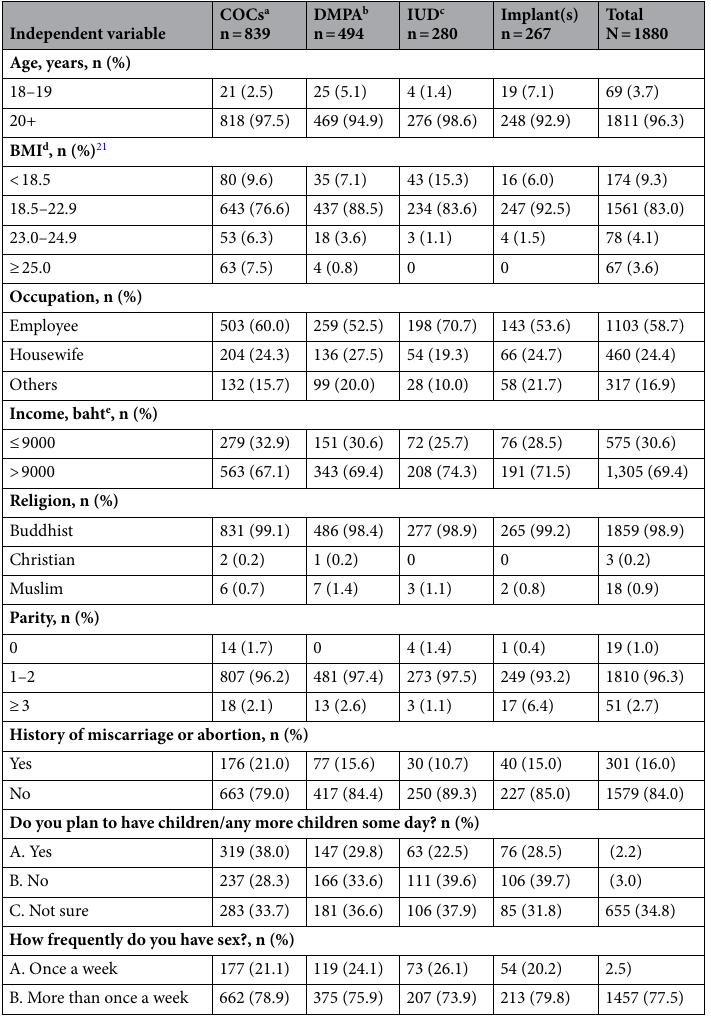
and “How frequently do you have sex?”, are also provided in Table 1. Most women had sex more than once a week. Almost all women (99.9%) were cohabiting or married. The cumulative probability of discontinuation for each contraceptive and all methods at three, six, and twelve months are shown in Fig. 1. Copper IUDs and contraceptive implant(s), considered LARCs, had low cumulative discontinuation rates during the 1-year period. None of the participants were lost to follow-up. The incidence rate for discontinuation of COCs was 21.3/100 person-years, which had the highest rate of discontinuation among all four methods. The incidence rate for discontinuation of DMPA was 9.2/100 person-years. Among the LARC group, the incidence rate for discontinuation of copper IUD was 4.4/100 person-years. The incidence rate for discontinuation of contraceptive implant(s) was 2.3/100 person-years, which was the lowest among all four methods. The survival probabilities of each contraceptive during the one-year period are shown in Fig. 2. The distribution of the main reason for the discontinuation of each contraceptive is shown in Table 2. Most women (185/222) discontinued their contraceptives because of side effects. The most common side effects for COC dis- continuation were nausea/vomiting (51/126) and headache (42/126). For DMPA, bleeding and spotting (35/41) were the major causes of discontinuation. For the copper IUD, pelvic pain and dysmenorrhea (10/12) were the main causes of discontinuation. For contraceptive implant(s), all women (6/6) stated that they discontinued their contraceptive implant(s) due to spotting. Among all women who discontinued their contraceptives, nine women had unintended pregnancy that ended in induced abortion. All of these women discontinued COCs. The unadjusted hazard ratio (HR) and adjusted hazard ratio (aHR) with a 95% confidence interval (CI) are shown in Table 3. The results show that the type of contraceptive, income level, parity, history of miscarriage and